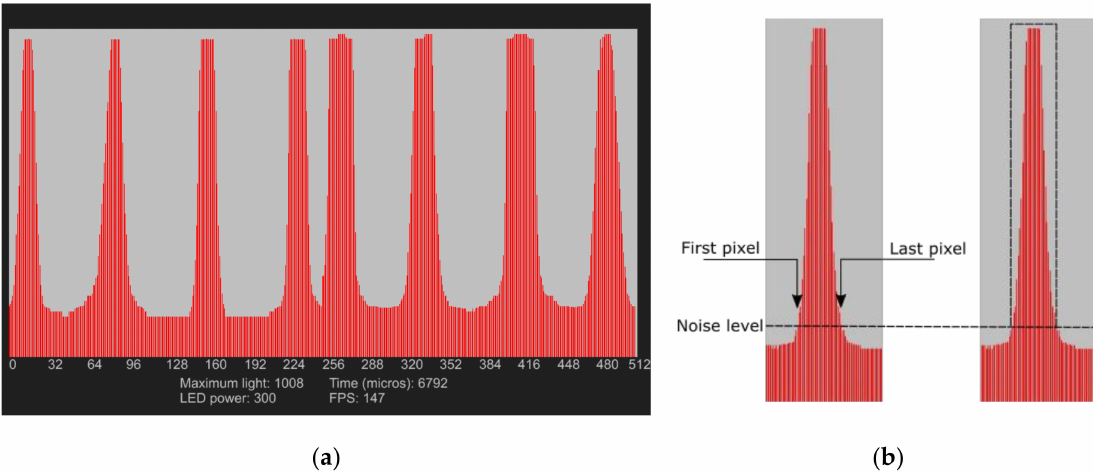
Figure 6. ( a ) Plot of the light level detected by the two arrays of photodetectors, the eight peaks are the light outputs of the eight fibers bottom coupled to the photodetectors array; and ( b ) light signal post-processing: the software individuates and store the first and last pixel position that detect a light power above a certain threshold (noise level), any variation of light power in this area will be interpreted as a pressure applied in one of the sensitive points of the